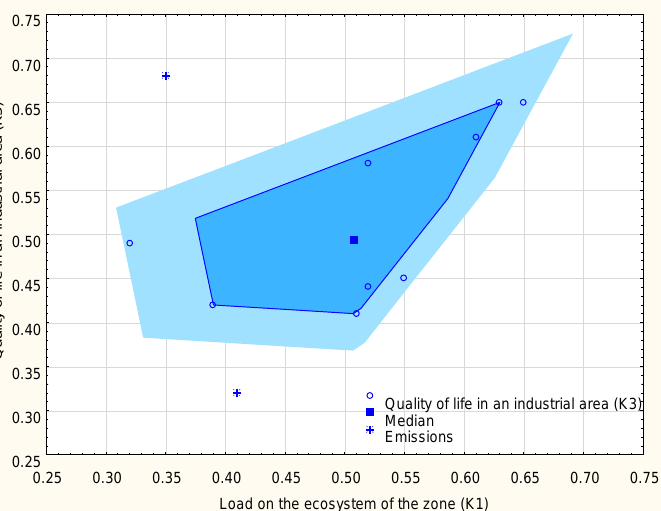
Figure 4. Criterion concentration chart K 1 – K 3 «Industrial zone ecosystem load — Industrial zone life quality».